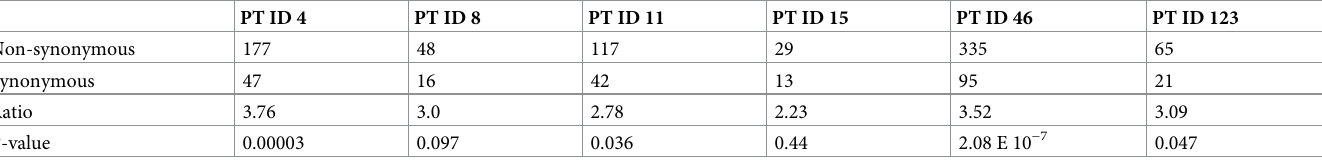
Table 2. Non-synonymous and synonymous mutations present in the primary